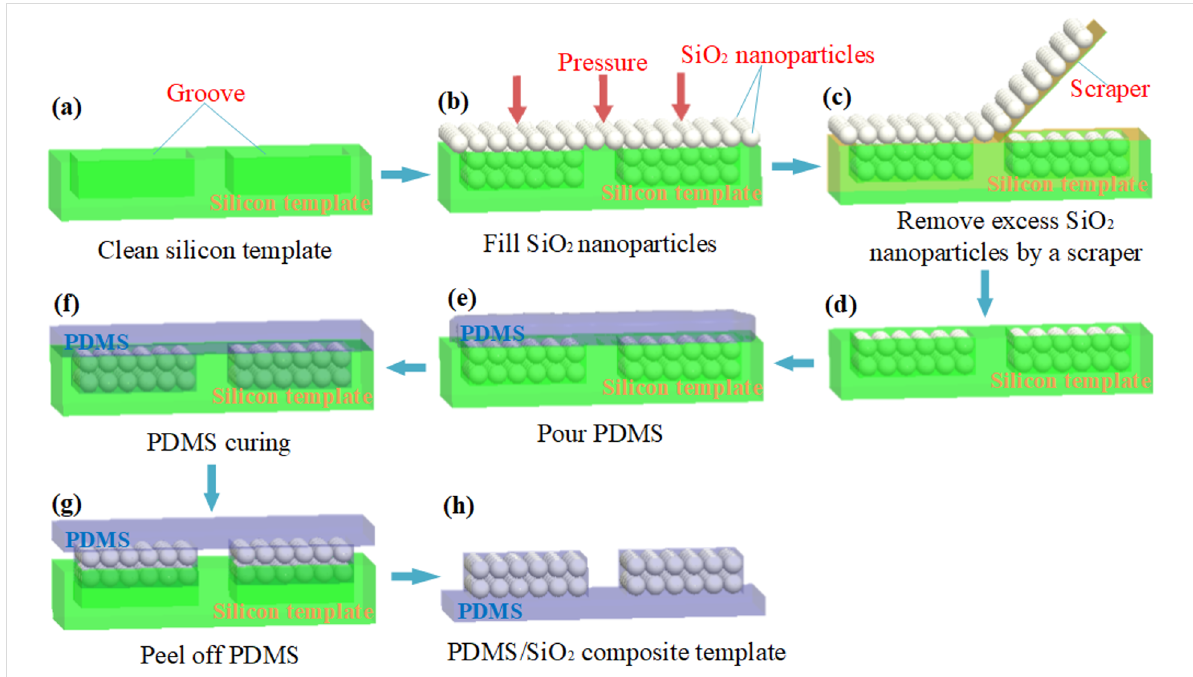
Figure 1: The experimental procedure for preparation of the PDMS/SiO 2 composite template via dry blending: (a) cleaning of the silicon template; (b) filling with SiO 2 nanoparticles; (c) removal of excess SiO 2 nanoparticles; (d) grooves filled with SiO 2 nanoparticles; (e) covering with PDMS; (f) curing of PDMS; (g) peeling off PDMS; and (h) prepared PDMS/SiO 2 composite template.